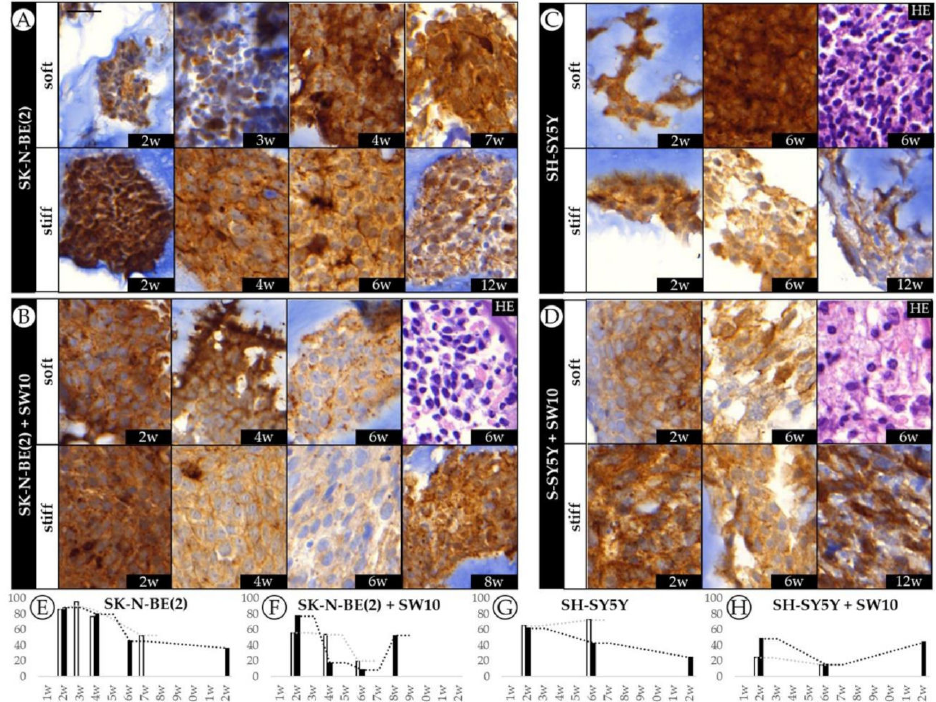
Figure 4. Dynamics of VN expression in SK-N-BE(2) and SH-SY5Y cell lines over time. ( A – D ) Representative images of VN expression at the time points studied (w: weeks) and hematoxylin eosin (HE) for each cell culture / co-culture in soft and sti ff sca ff oldings. The images on the left correspond to the SK-N-BE(2) cell line cultivated ( A ) alone and ( B ) with SW10; the images on the right represent the SH-SY5Y cell line cultivated ( C ) alone and ( D ) with SW10 cells. Scale bar 25 µ m at top left of the first image. Same scale bar is valid for all images. ( E – H ) Bar chart quantification of VN staining (% of stained area) for SK-N-BE(2) cells ( E ) alone and ( F ) SK-N-BE(2) cells plus SW10 cells in soft and sti ff sca ff olds, and SH-SY5Y cells ( G ) alone and ( H ) S-SY5Y cells plus SW10 cells in soft and sti ff sca ff olds. White and black bars: soft and sti ff sca ff olds, respectively. Dashed lines indicate moving average per sti ff ness condition. X axis: time in weeks (w) and Y axis: % of VN stained area.